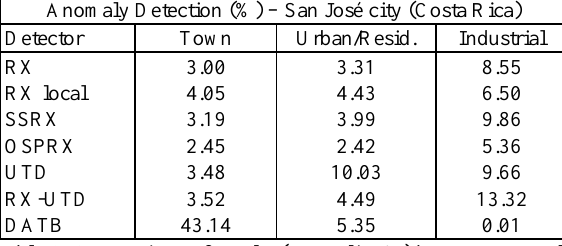
Table 2. Comparison of results (anomalies %) between anomaly detectors for San José city in relation with the full scene (1228656 pixels). Figure 6. ROC curves for San José MASTER test data set (up) and for Alcalá de Henares AHS test data set